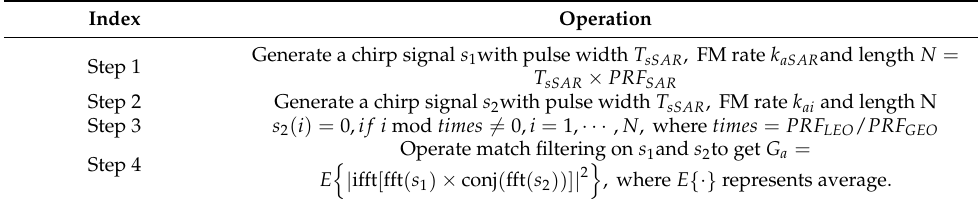
Table 1. Steps of the numerical